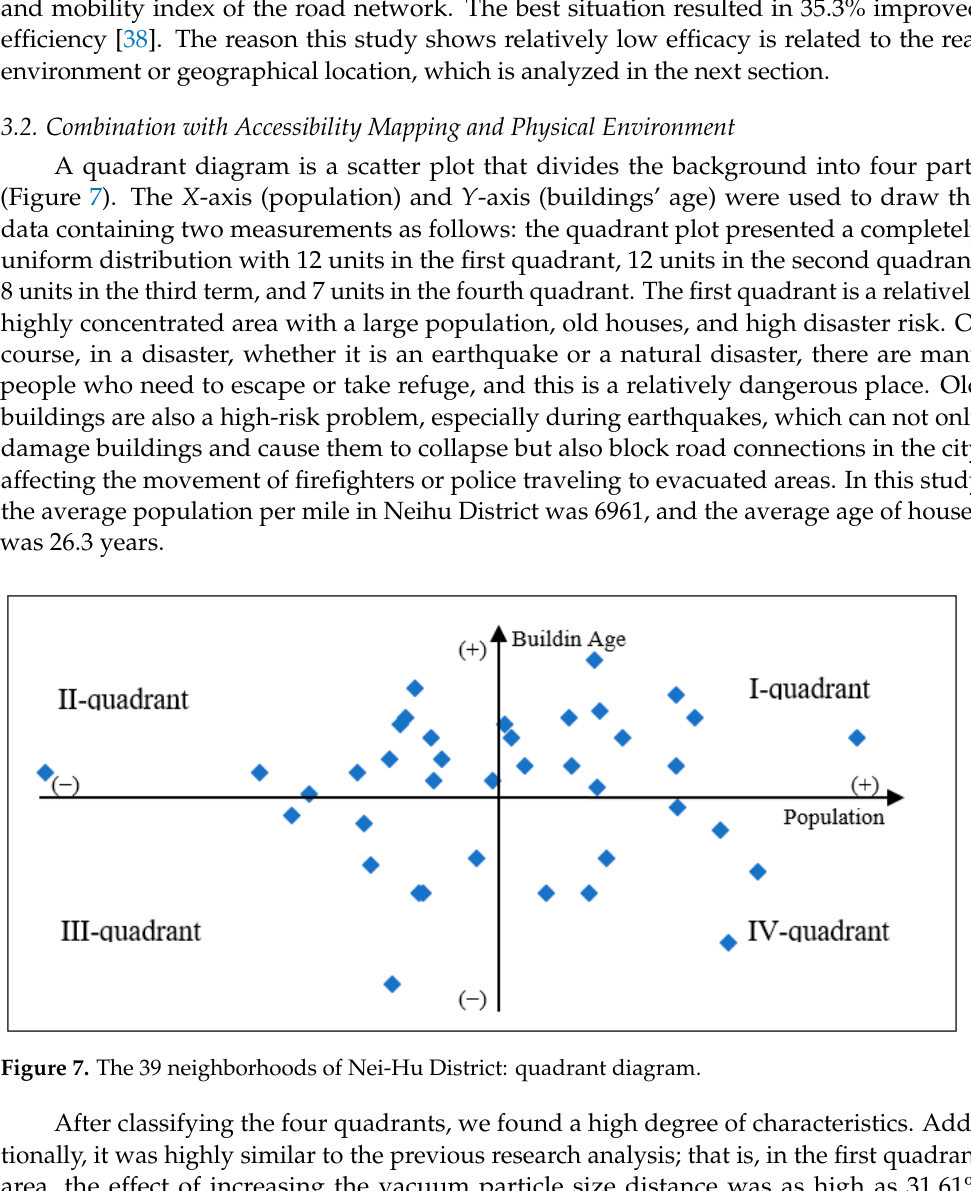
Table 2. Comparison chart of four-quadrants diagram.